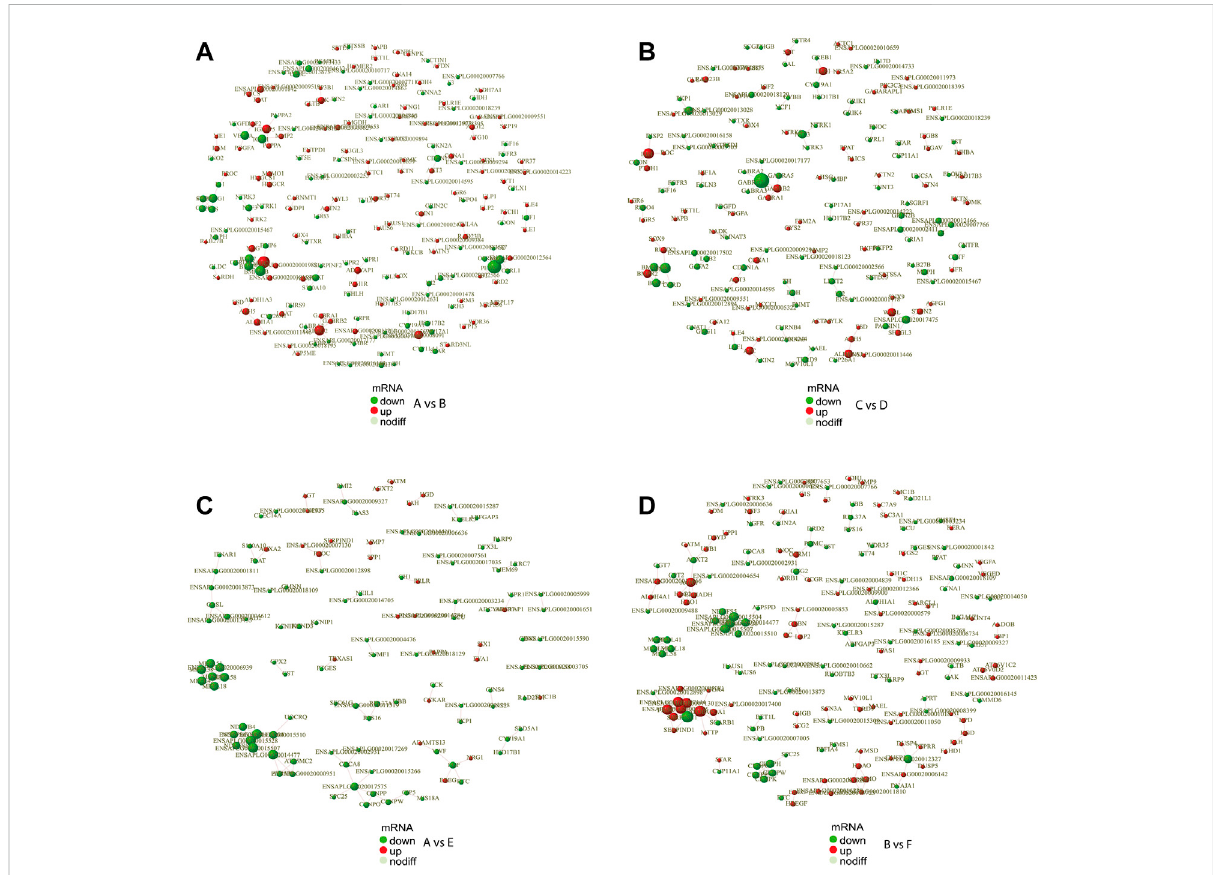
FIGURE 4 PPI network of DEGs. PPI network exhibits both protein interactions and expression levels. The dots indicate protein-encoding genes. Red indicates up-regulated genes, and green denotes down-regulated genes. PPI, protein-protein interaction; DEGs, differentially expressed genes. (A) PPI network of DEGs between female and male Mule ducks. (B) PPI network of DEGs between female and male Jinding ducks. (C) PPI network of DEGs between Mule duck and Muscovy duck females. (D) PPI network of DEGs between Mule duck and Muscovy duck